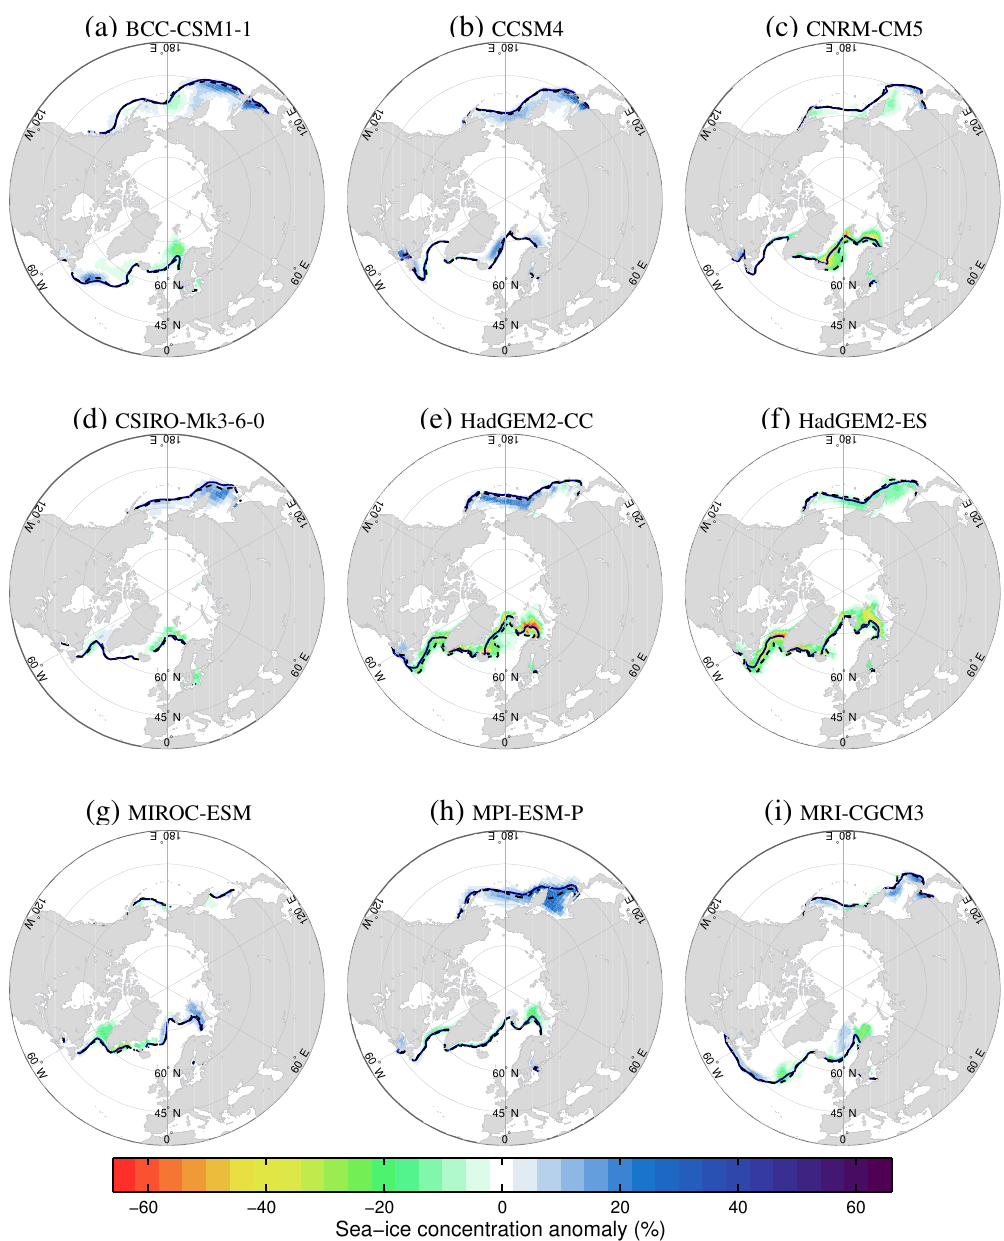
Figure A2. MH winter (March) sea ice concentration anomalies (in %, with respect to the PI reference period) and location of the ice edge for 6ka (solid lines) and for the PI period (dashed lines), defined as the 15% concentration limits.